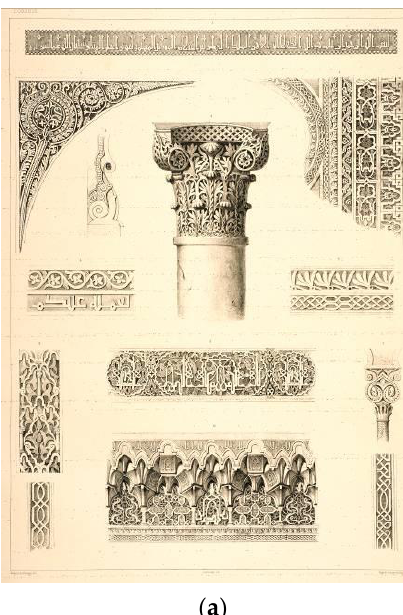
Figure 8. Girault de Prangey: ( a ) Royal Chapel side view (Villemin, lit.); ( b ) Section-elevation and details from mihrab (Dumouxa, lit.). Source: Monuments arabes et moresques de Cordoue, 1839.